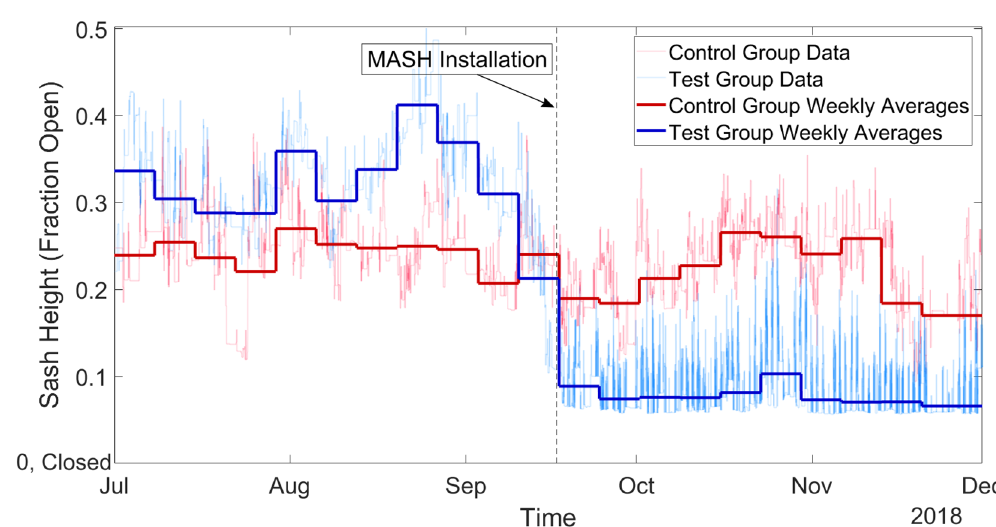
Figure 4. Test hoods versus control hoods. This figure shows the average sash heights of the test and control groups, as recorded every 15 min (lighter colored lines), overlaid with the weekly average sash heights of both groups (bold). After the installation of the MASH alarms, the sash heights of the control group remained relatively unchanged, but the test group exhibited a significant drop in average sash heights. (A value of 0.07 or below corresponds to a closed fume hood sash in the KGS Clockworks